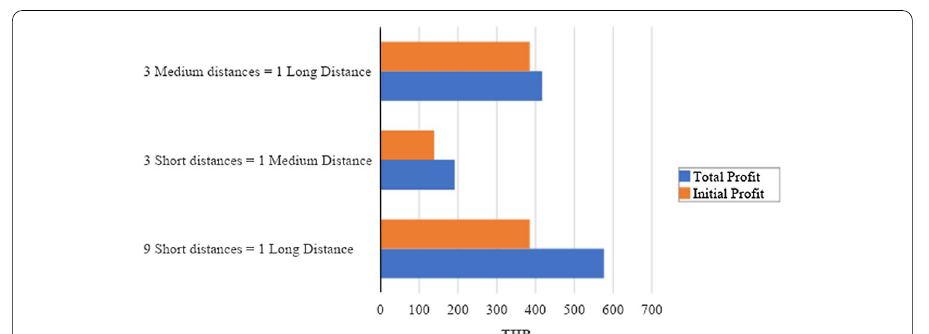
Fig. 12 Comparison of trip distances and